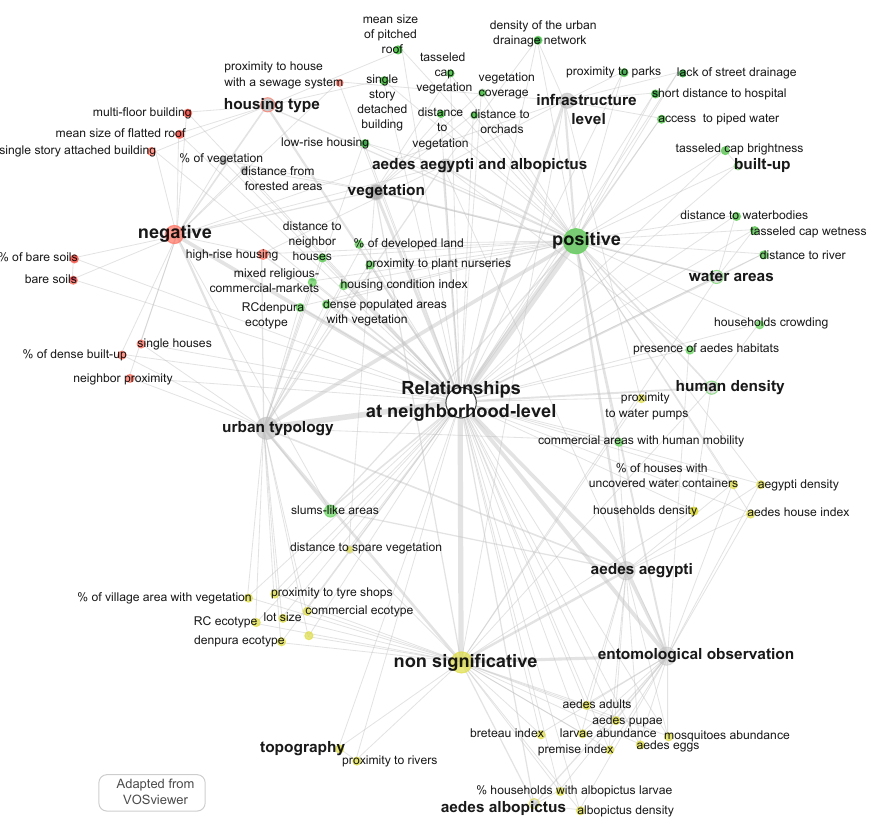
Figure 8. Co-occurrences network mapping of the self-defined keywords related to the landscape factors considered at